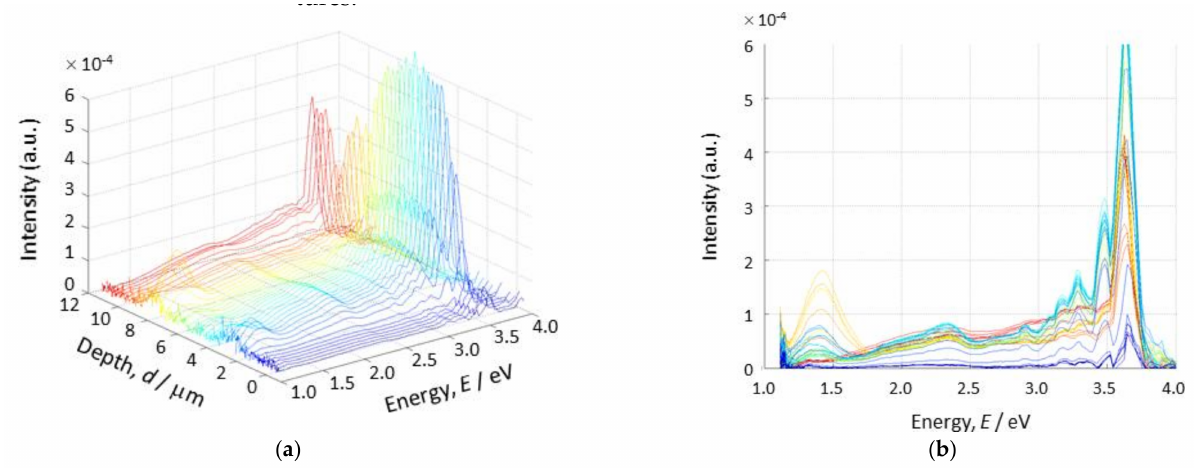
Figure 4. The photoluminescence spectra obtained by the spectrometer during a depth scan. ( a ) Three-axis plot of the emission energy, position (depth), and emission intensity, and ( b ) intensity vs. energy, in which several peaks can be